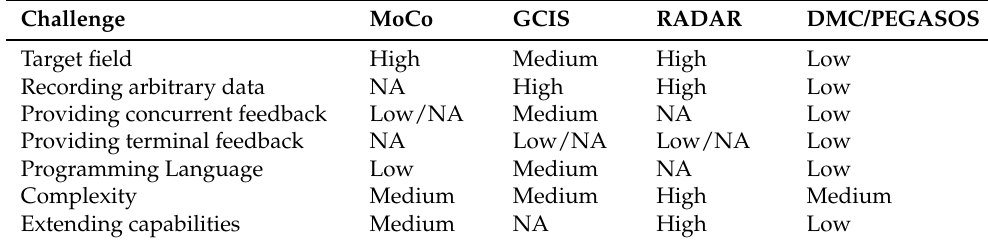
Table 1. Challenges for potential first-time